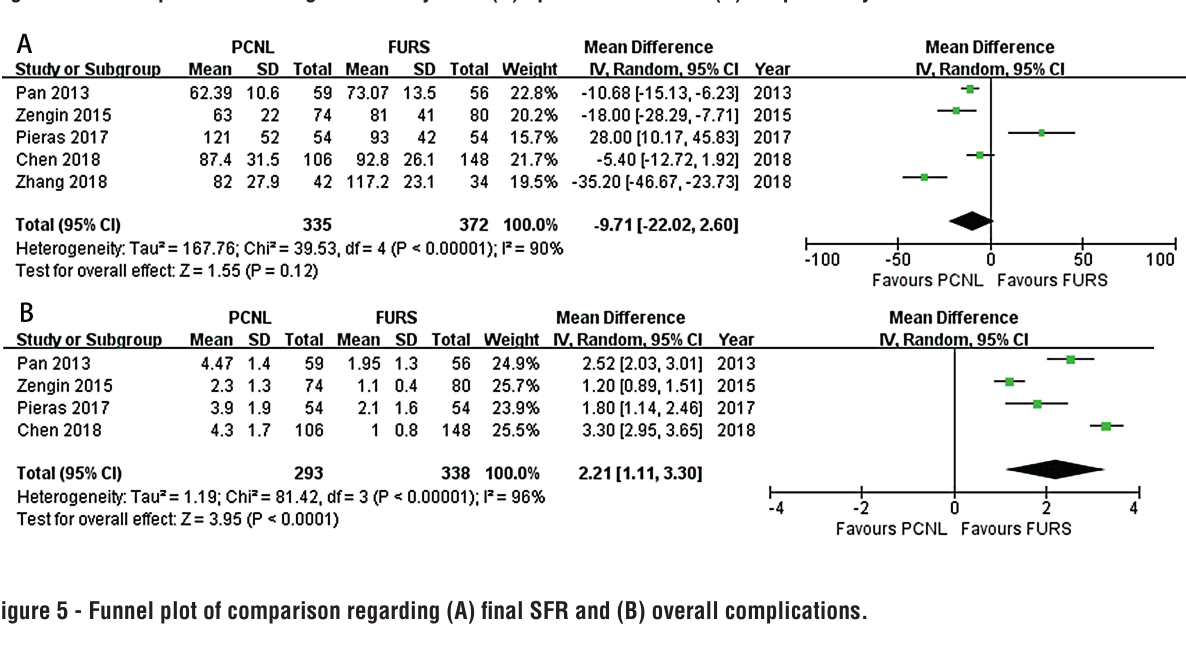
Figure 4 - Forest plots illustrating meta-analysis of (A) operative time and (B) hospital stay.